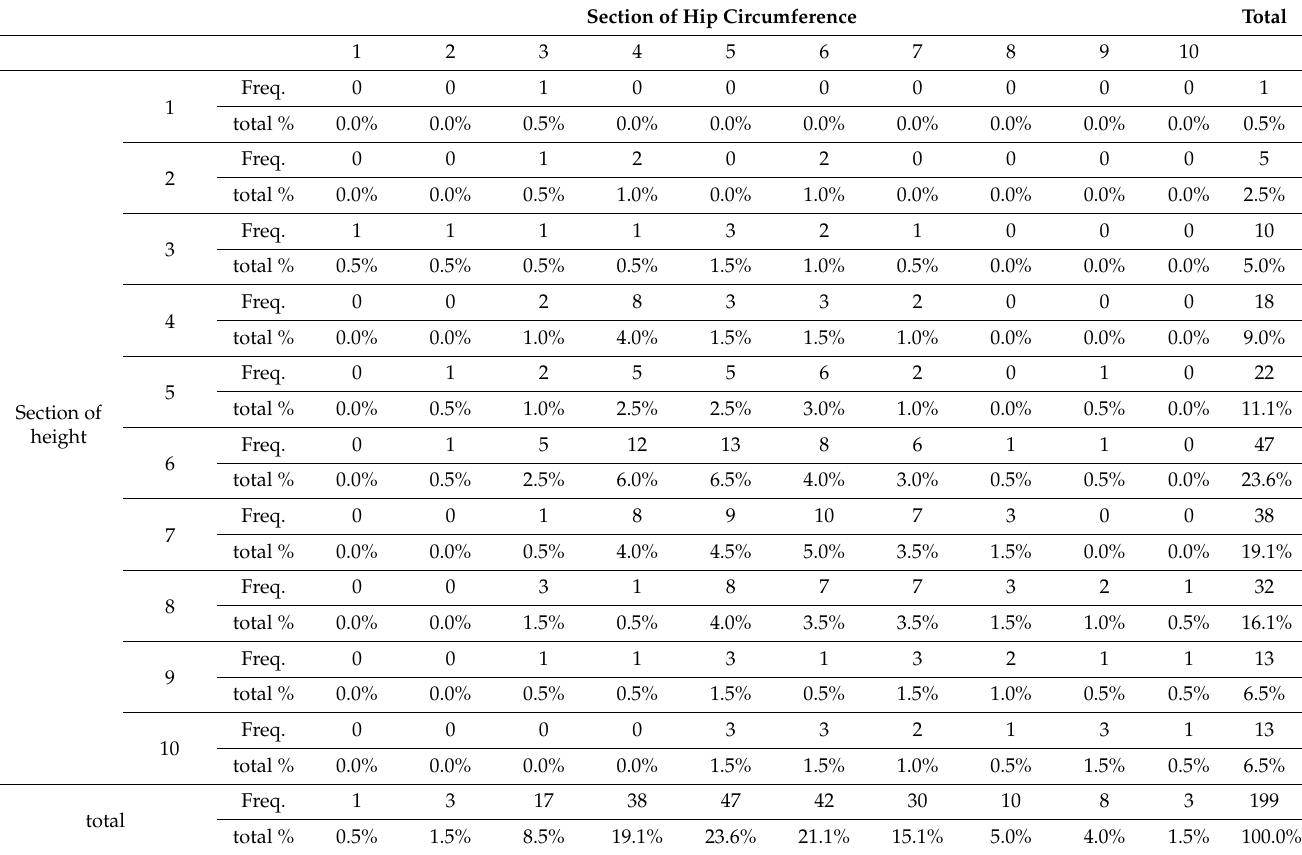
Table 5. Results of primary cross-tabulation